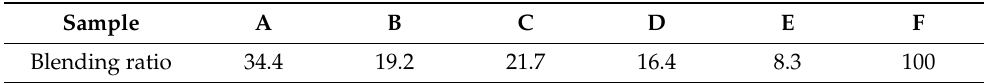
Table 9. Blending ratio of sample F (%).